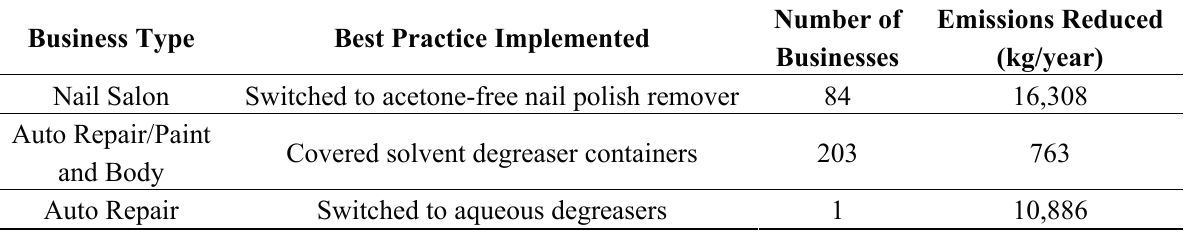
Table 3. Emissions reduced by the adoption of best practices at nail salon, auto repair, and hair salon businesses.